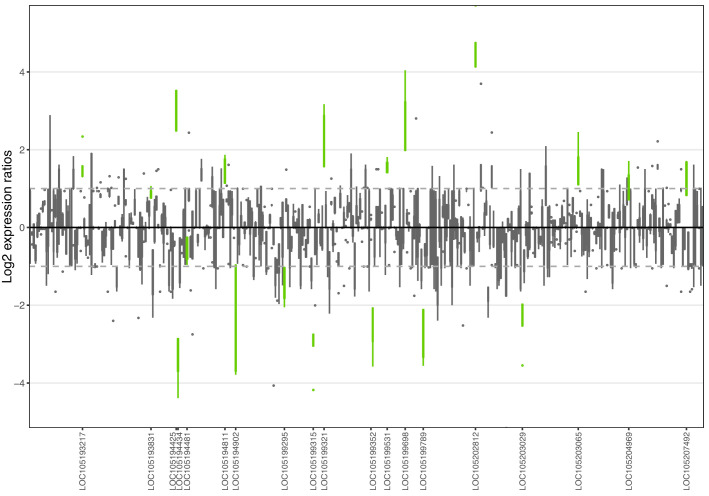
Allele-specific expression for genes in the fire ant social supergene) for whole bodies of Taiwanese queens.Differences in allele-specific expression between variants (y axis) for all genes in the supergene with enough expression information (x axis). Significant expression differences (BH adjusted p<0.05 from Wald test in DESeq2) are in green and the RefSeq ID of the significant gene is outlined in the x axis. Non-significant differences are in gray. Within each plot, each box shows the distribution of log2 expression ratios between SB and Sb. Positive values indicate higher expression in SB; negative values indicate higher expression in Sb. The dashed line shows log2 expression ratios = 1, that is a two-fold gene expression difference in either direction. Genes are in chromosomal order, showing that genes with allelic biases in either direction are distributed throughout the supergene, rather than localized in a manner that would be expected by strata of differentiation. Thicker boxes have higher median read counts than thinner boxes.Figure 1—figure supplement 4—source data 1.Allele-specific expression for genes in the fire ant social supergene) for whole bodies of Taiwanese queens.The columns in the dataset stand for: refseq_id, gene ID in the RefSeq database; body_part, body part from which the RNA was extracted; median_expression, median DESeq2 normalized expression per gene across all samples per body part; littleb_expression, DESeq2 normalised read counts for the Sb allele, bigB_expression, DESeq2 normalised read counts for the SB allele; sample_id, ID for the replicate; population, population of origin of the replicate, total_expression, combined SB Sb expression per gene per replicate; lfc_SB-Sb, log2 fold changes between SB and Sb DESeq2 normalized read counts; significant, whether a gene show significant differences in expression levels between Sb and SB according to either our linear mixed effects model or DESeq2's Wald test.